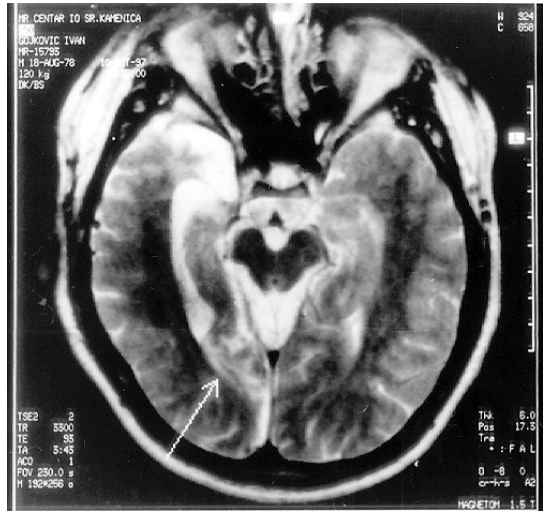
Fig. 1. A T2 weighted MR image shows high intensity lesion in the right occipital lobe (arrow). drawals from testing in order to eat or sleep.